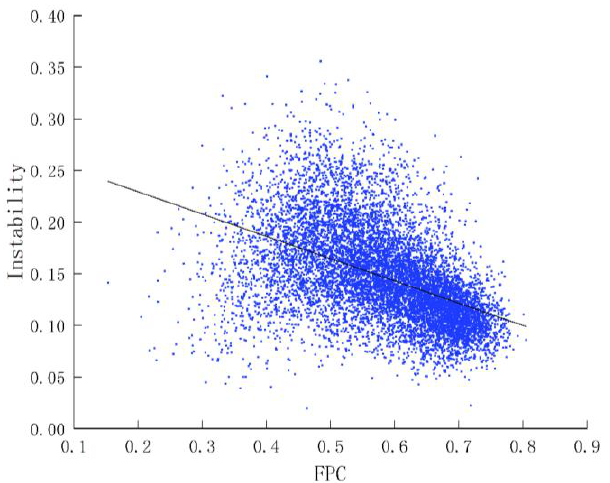
Figure 8. Scatterplot of FPC and instability. Table 4. Area statistics corresponding to FPC grades.